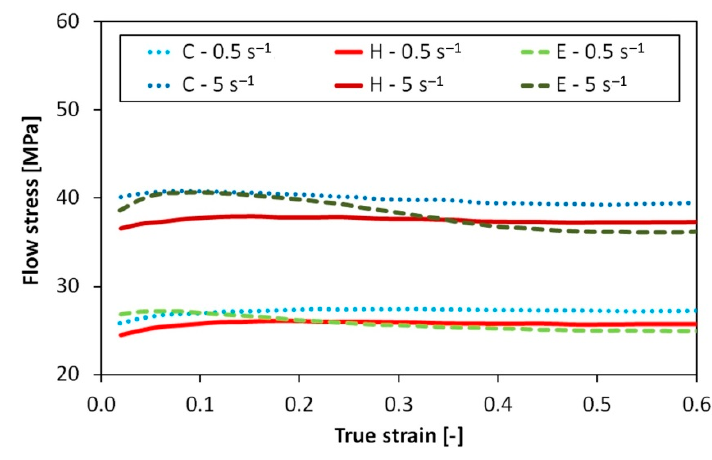
Figure 8. Stress-strain curves for a temperature of 550 °C